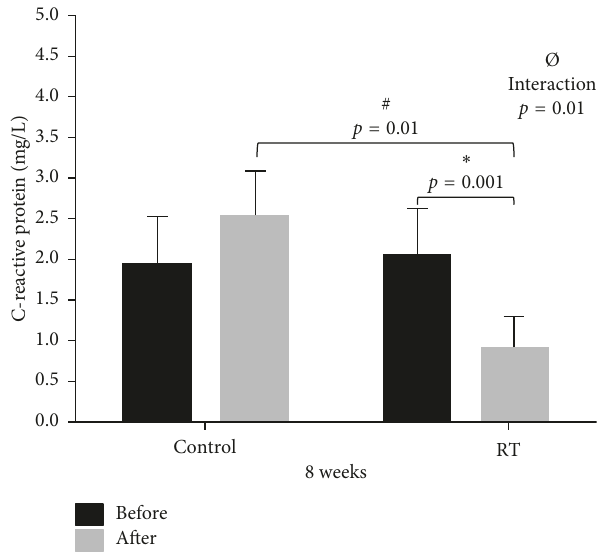
Figure 5: Dispersion measurements of C-reactive protein between Control ( n � 10) and RT ( n � 19) groups at Pre and Post moments. Two-way ANOVA test: ∗ statistically significant difference ( p � 0 . 001) between Pre and Post moments in the RT group; # statistically significant difference ( p � 0 . 01) between Post mo- ments in the RT vs Control groups; Ø statistically significant in- teraction ( p � 0 .